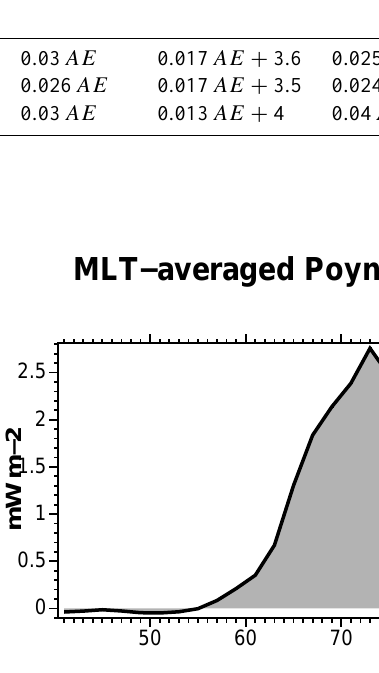
Fig. 4. Average global (ILAT 25–90) Joule heating for all K p values and all MLT sectors. At latitudes above ILAT 60 we have an average downward Poynting